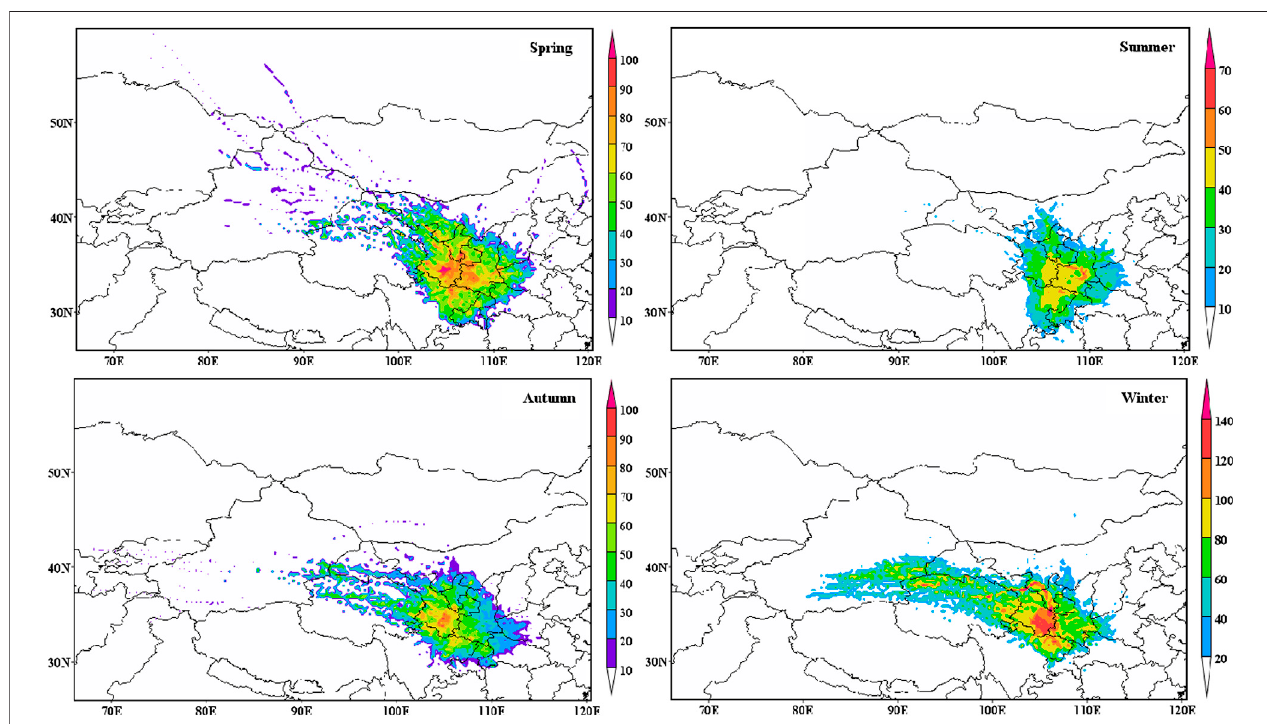
FIGURE 10 | Weighted concentration weighted trajectory distribution of PM10 in different seasons ( μ g m − 3 ).